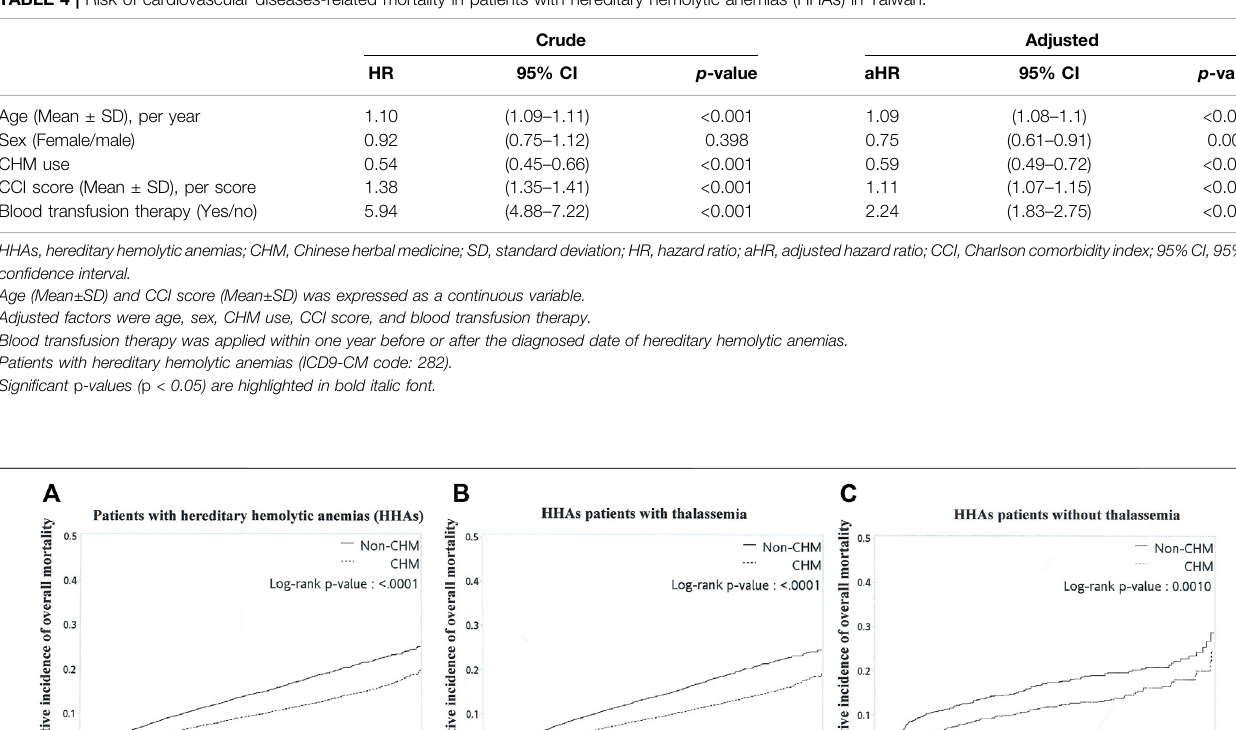
Table 1 ). After matching, the differences between the 9,222 non- Table 1 ). The CHM-users continued to use CHMs during the follow-up period ( Supplementary Table S1 ).